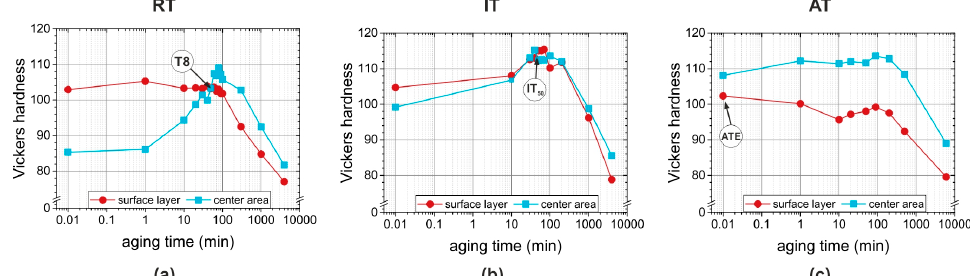
Figure 5. Vickers hardness plots of the surface layers and the center areas of the extruded materials as a function of aging time at 170 °C for ( a ) RT-extrusion; ( b ) IT-extrusion (120 °C); and, ( c ) AT-extrusion (170 °C). Material conditions with the highest homogenous hardness (“optimized” material conditions) are marked for all the extruded materials (labels in circles).